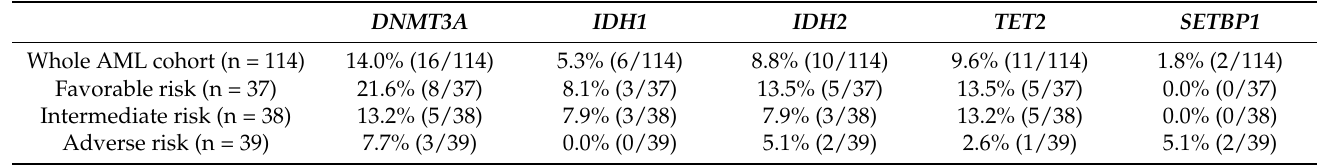
Table 2. Incidence of DNA methylation regulatory gene mutations in the whole cohort and among ELN risk